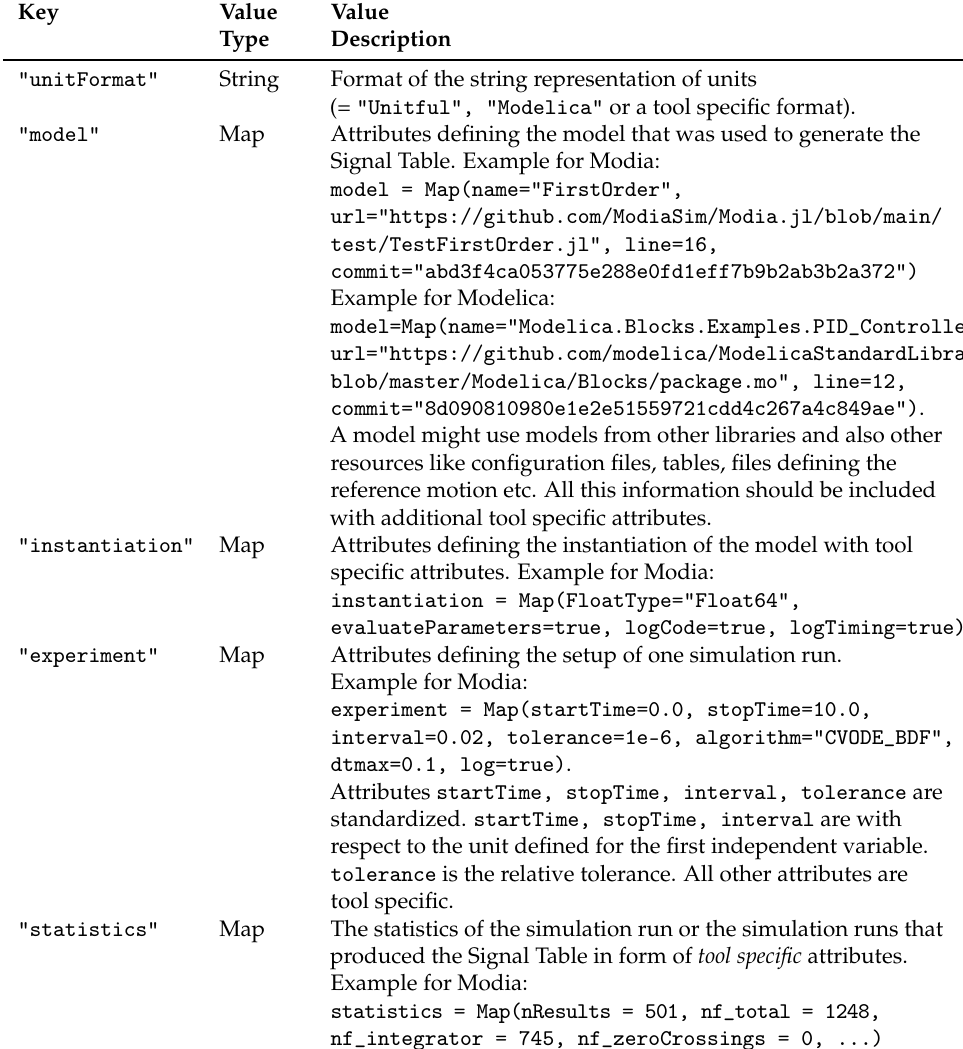
Table A3. Predefined attributes for Map dictionaries. A Signal Table can have an optional key "attributes" that is a Map with the optional attributes below.